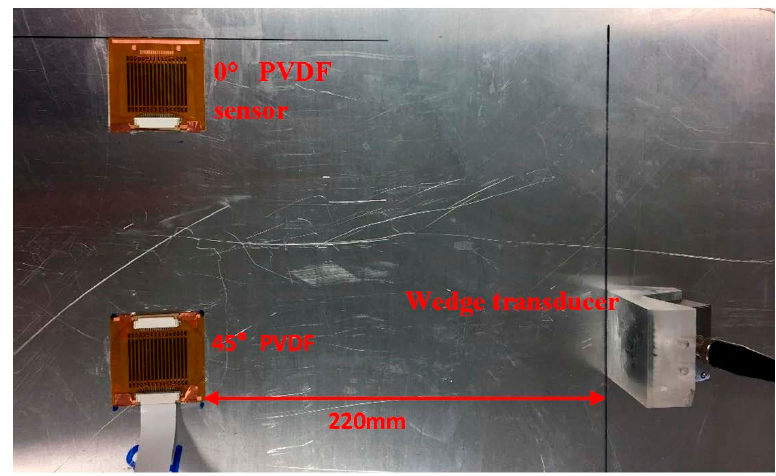
Figure 8. Experimental setup for PVDF sensors to receive Lamb waves.